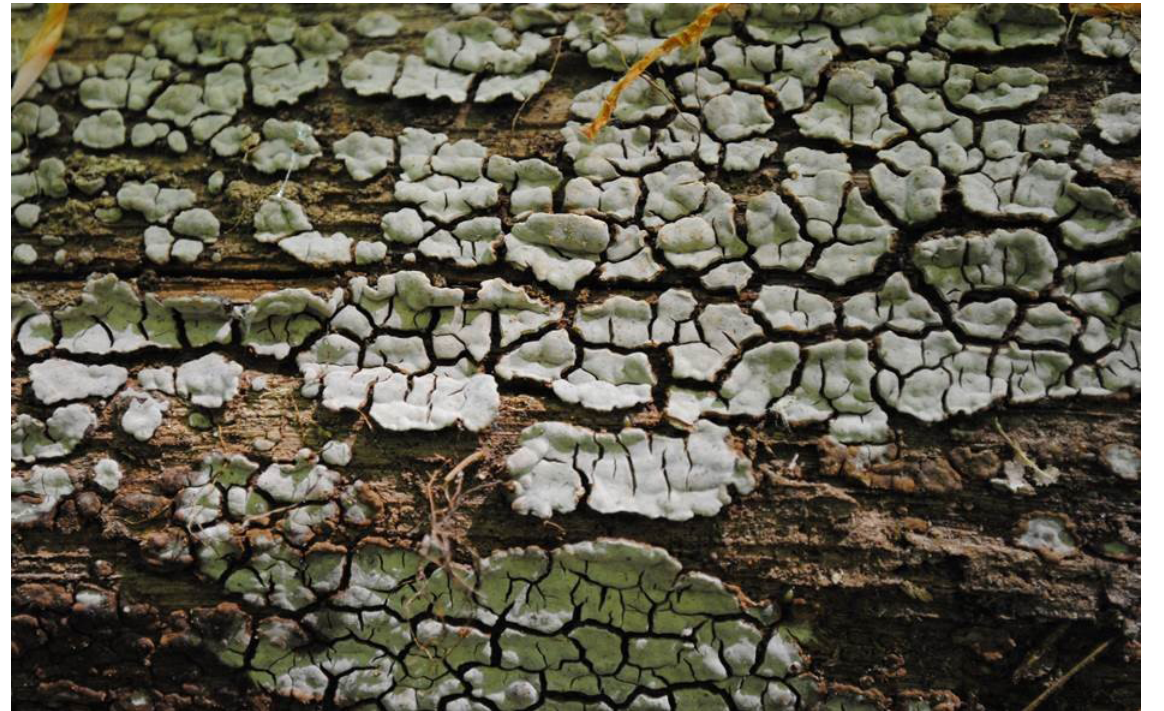
Figure 2 Basidiomata of Xylobolus frustulatus from the Wolin National Park (August 13, 2017). Photography by